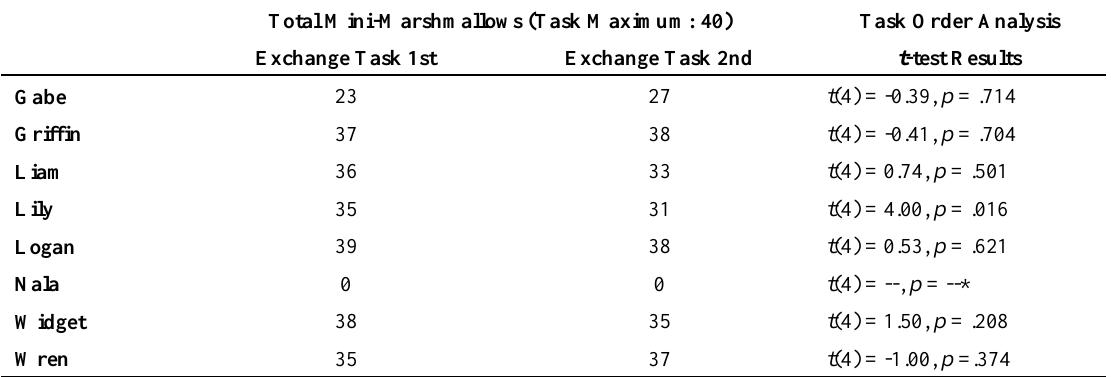
Exchange Test Performance from Experiment 2 when the Task was Presented First (Prior to Accumulation) Versus Second (After Accumulation) Total Mini-Marshmallows (Task Maximum: